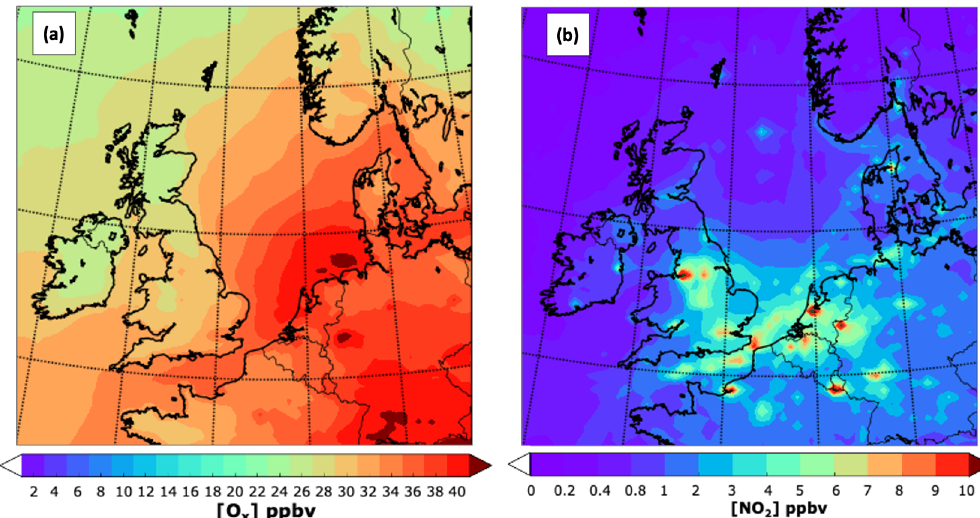
Figure 5. Close-up of the spatial distribution for July 2015 of (a) the mean O x mixing ratio (O 3 + NO 2 ) and (b) NO 2 . Note the different